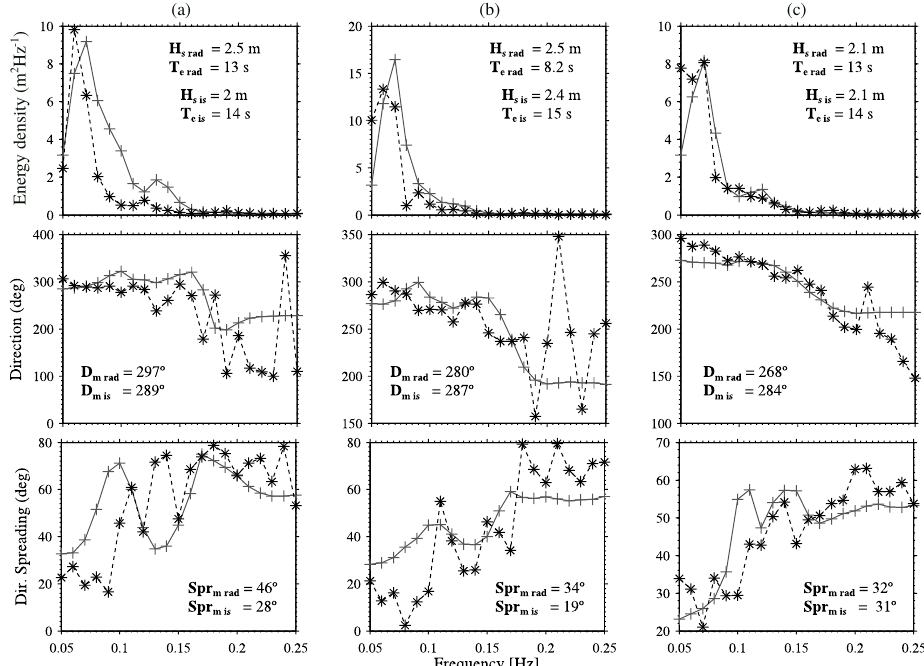
Figure 6. Radar and in situ estimates of one-dimensional spectra, mean direction and directional spreading as a function of frequency on 21 October 2012 at 1000 UTC: ( a ) ADCP-E (dashed black line and *) and radar (grey line and +); ( b ) ADCP-W (dashed black line and *) and radar (grey line and +); and ( c ) buoy (dashed black line and *) and radar (grey line and